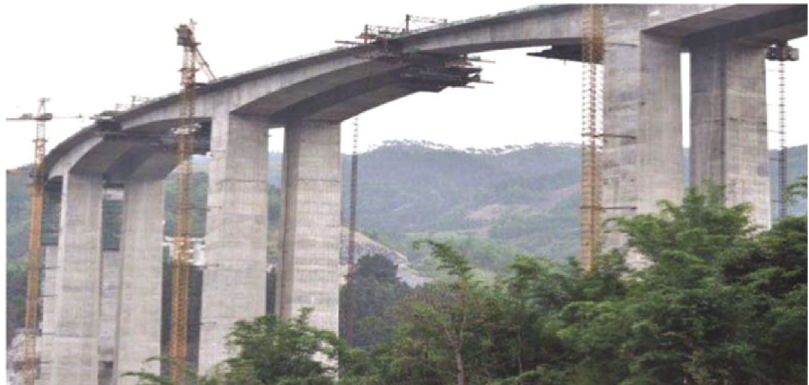
Figure 2: Single-limb thin-walled pier under